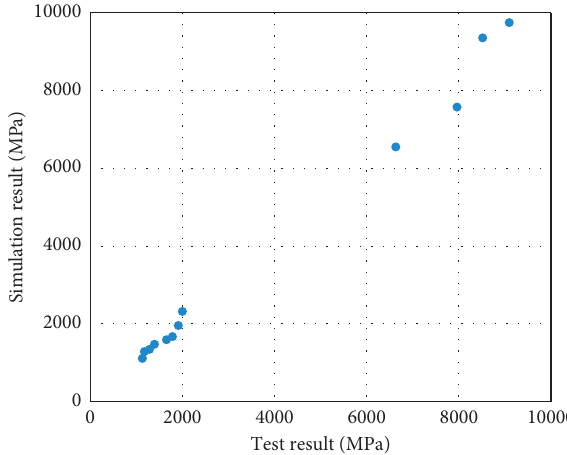
Figure 10: Test results vs. simulation